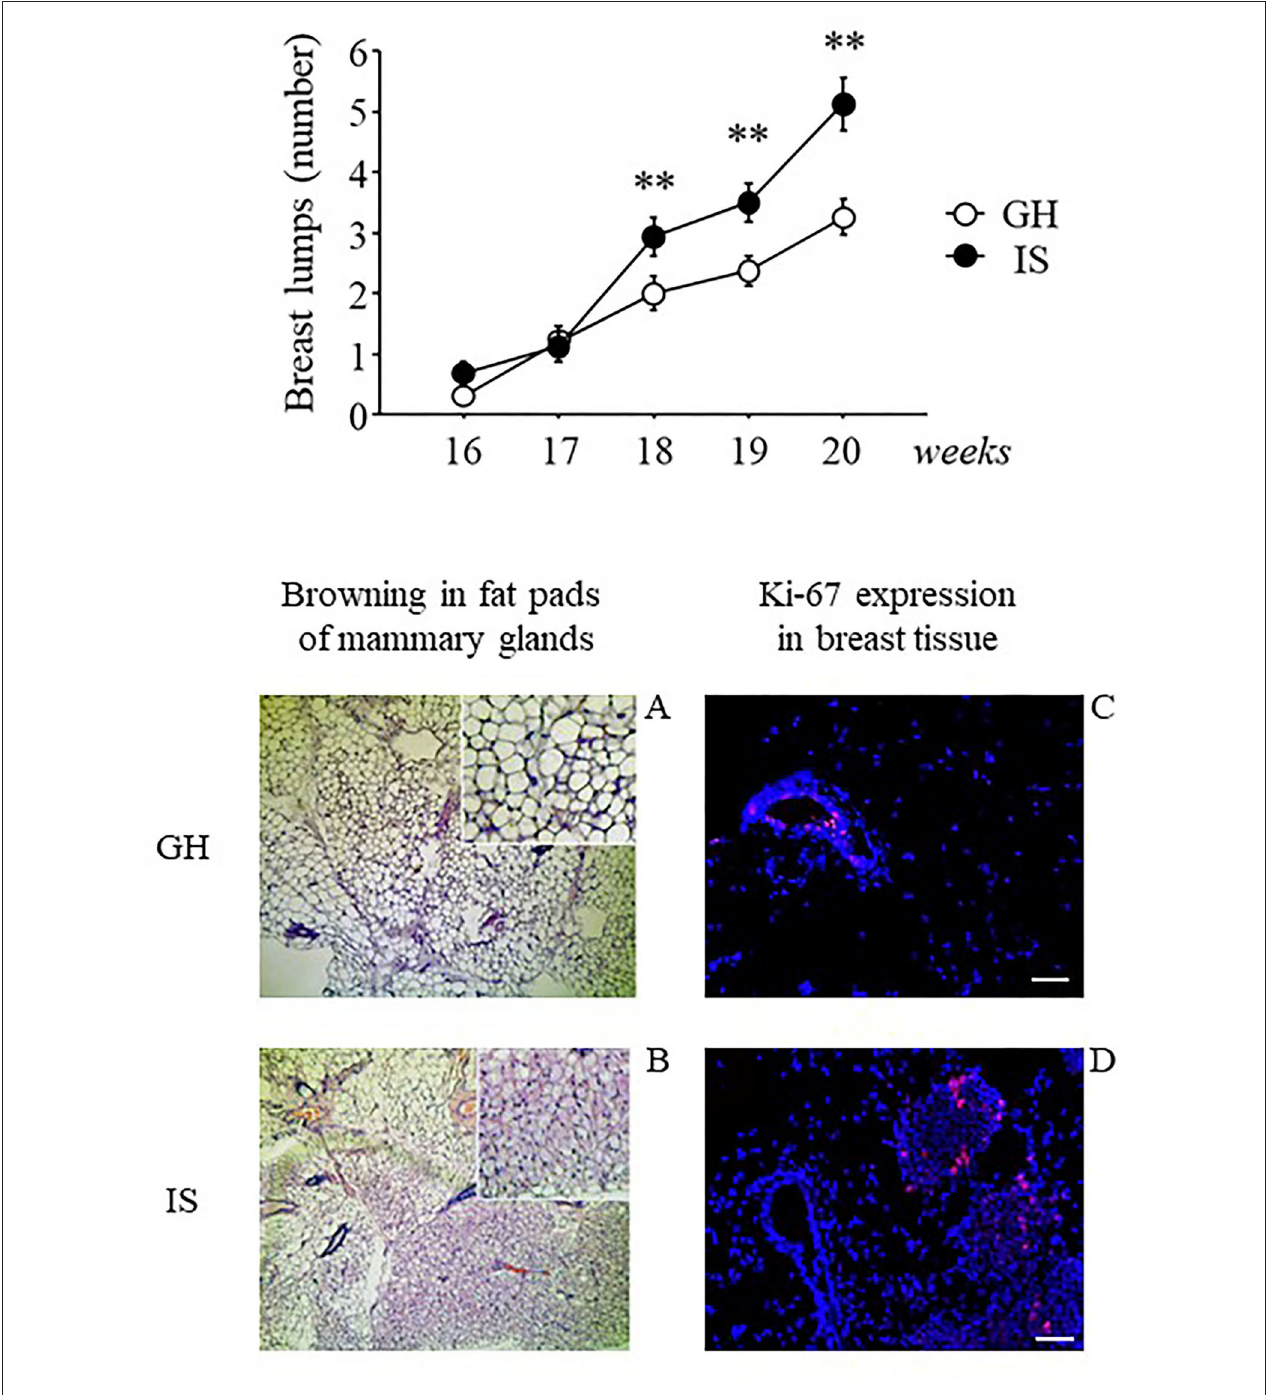
FIGURE 5 | Breast lumps and histological analysis of breast tissues from the MMTVNeuTg female mice. Breast lumps and fat browning in the fat pads of the MMTVNeuTg female mice. Isolation stress resulted in a time-dependent increase in the number of breast lumps in the breast cancer susceptibility MMTVNeuTg mouse model, suggesting an acceleration in tumor onset (upper panel). Moreover, when compared with the GH condition (lower panel, A and C ) chronic IS promoted the development of brown adipose tissue and was associated with a greater number of Ki-67 + cells (red nuclei) in the mammary gland (lower panel, B and D ). Data are presented graphically as means ± SEM (upper panel). Post-hoc comparisons: ** p < 0.01. Number of subjects: IS (16); GH (19). Lower panel: representative sections from mammary fat pads ( A and B ) and mammary gland ( C and D ), immunostained with Ki-67 (red) and counterstained with Hoechst (blue). Scale bar = 50 µ m.